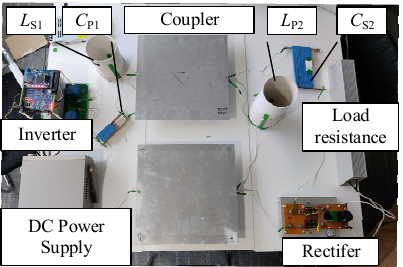
Figure 14. System efficiency versus load resistance variations.